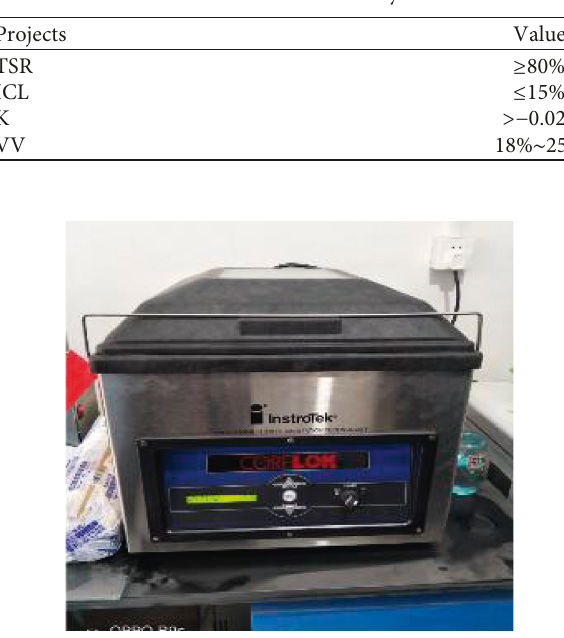
Figure 5: Corelok device.